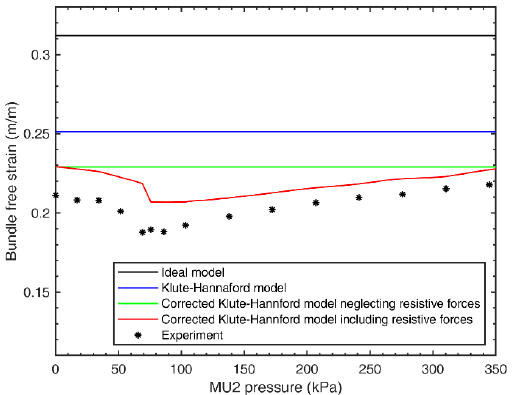
Figure 13. Free strain of actuator bundle versus pressure applied to motor unit (MU) 2 shown for the ideal model, the Klute–Hannaford model [20], the corrected Klute–Hannaford model neglecting resistive force, the Klute–Hannaford model including resistive forces, and experimental data. The pressure of MU 1 is kept constant at 344.7 kPa. The free strain initially decreases in response to increased pressure in the second recruitment state.